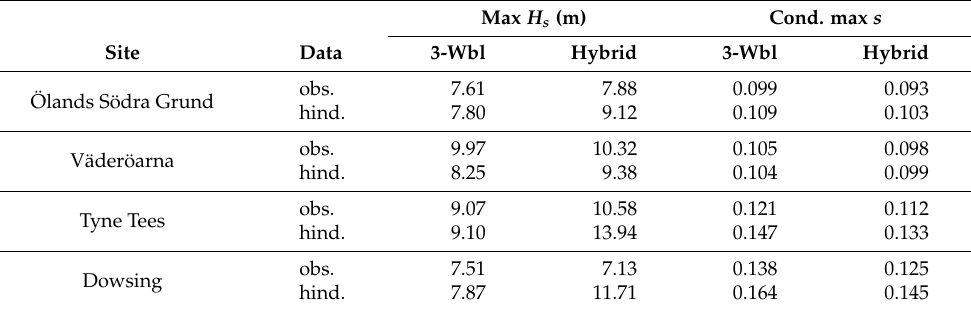
Table 2. Comparison between the 3-parameter Weibull fit and the hybrid fit (Equation (2)) for the I-FORM method. The maximum value of H s along the 50-year contour is shown. Also shown is the maximum steepness s , conditioned on H s > H s ,max /2 where H s ,max is the maximum value of H s for the observations at each site. Max H s (m) Cond. max s Site Data 3-Wbl Hybrid 3-Wbl Hybrid obs. Ölands Södra Grund